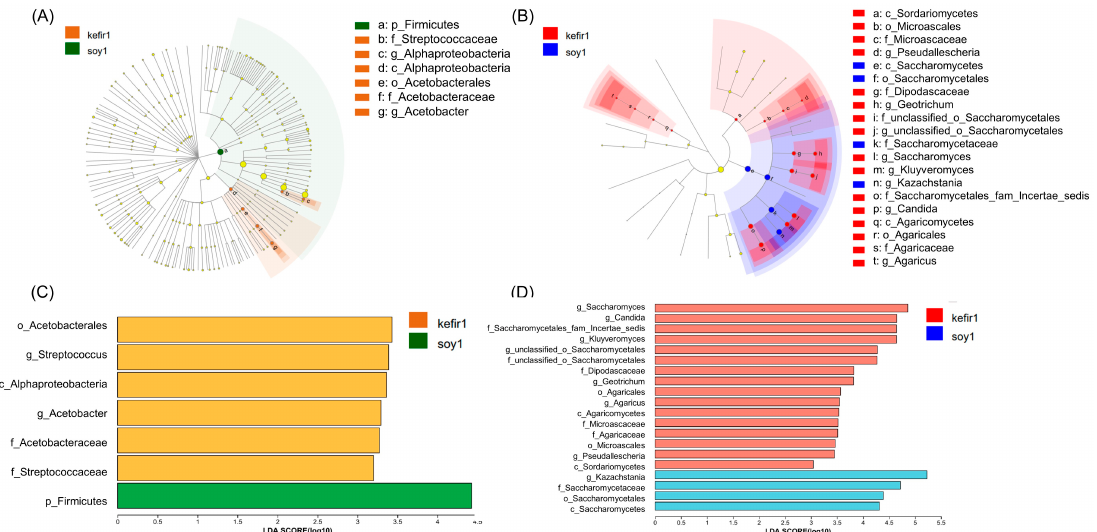
Figure 6. Taxonomic cladograms of bacteria ( A ) and fungi ( B ) produced from LEfSe analysis. Signifi- cant discriminant taxon nodes in kefir grains and soybean kefir grains are represented by dark yellow and green for bacteria and red and blue for fungi, and the nodes in light yellow show the OTUs with no significant difference. Bar charts of LDA values of differential bacteria ( C ) and fungi ( D ) in kefir grains and soybean kefir grains (LDA value > 2, p < 0.05). The LDA score implies the level of differentiation between the two groups.